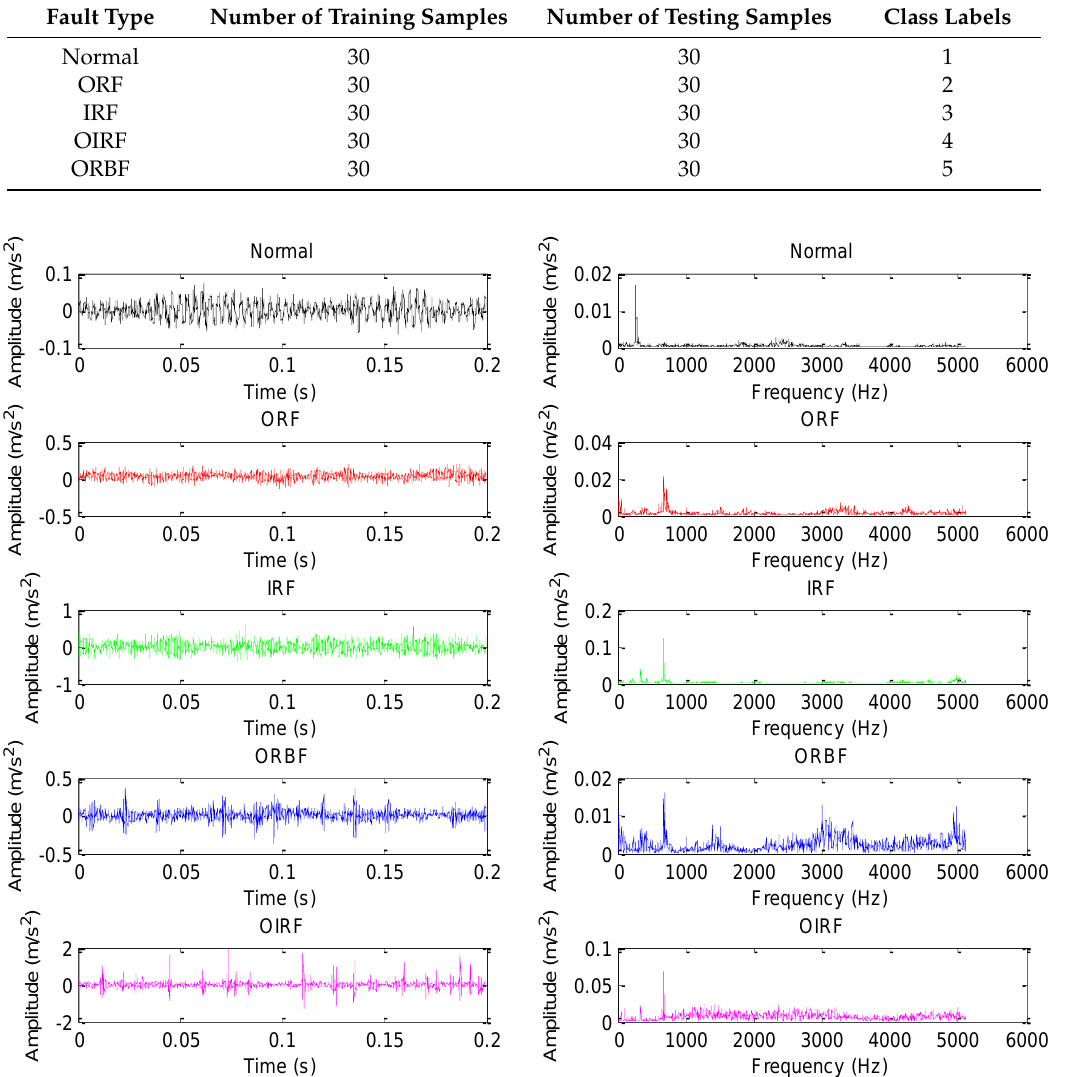
Figure 11. Waveform and spectrum of different bearing vibration signals.